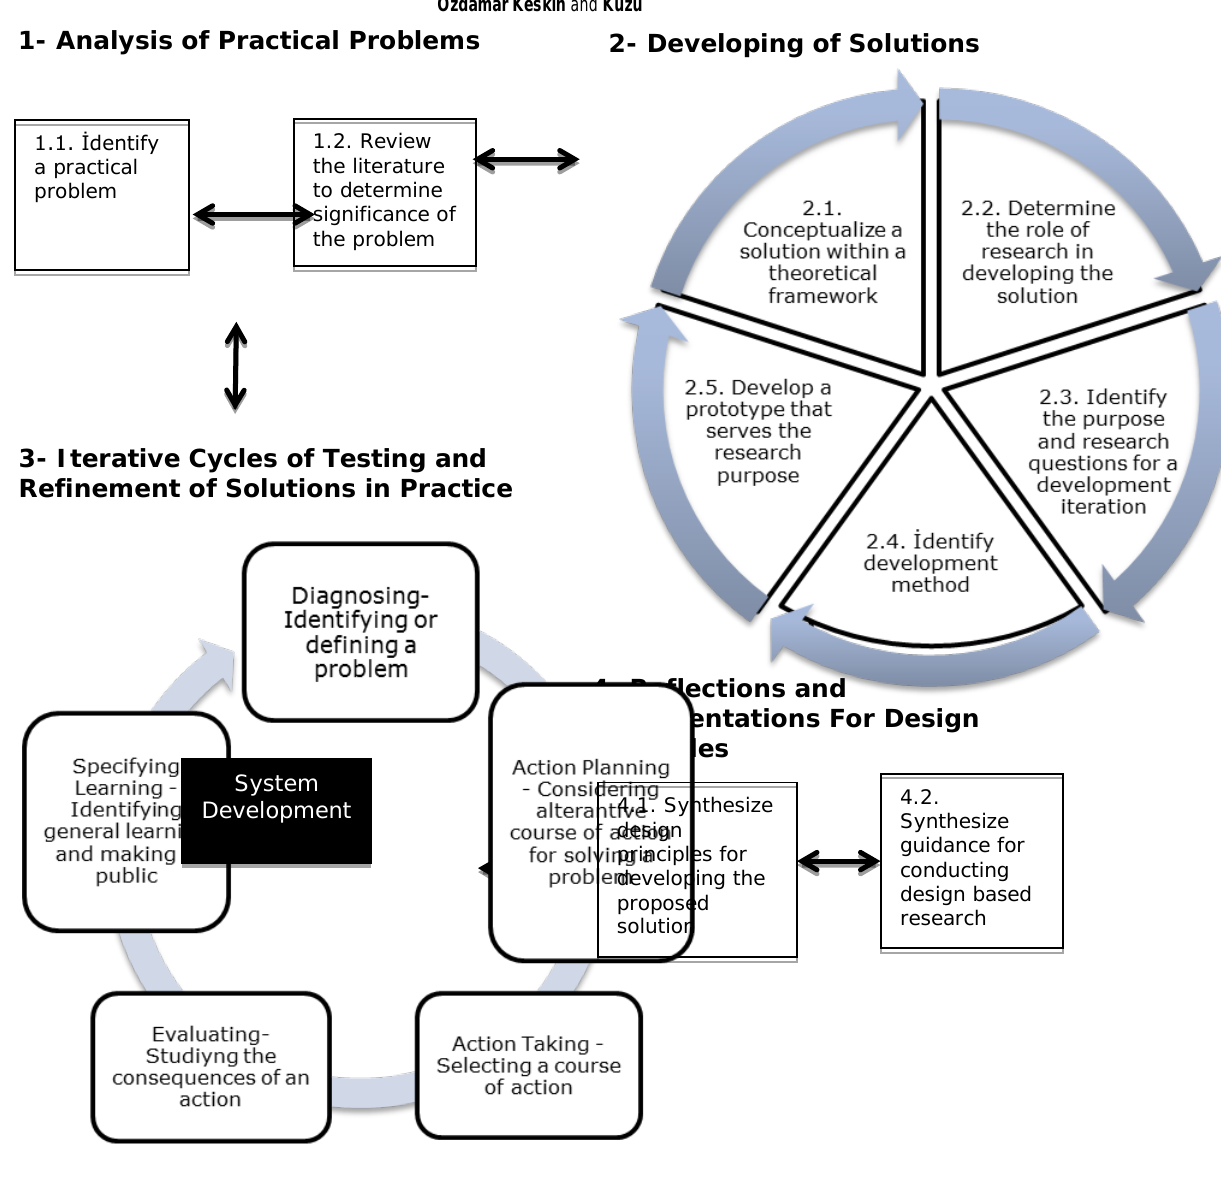
Figure 1 . Design-based action research